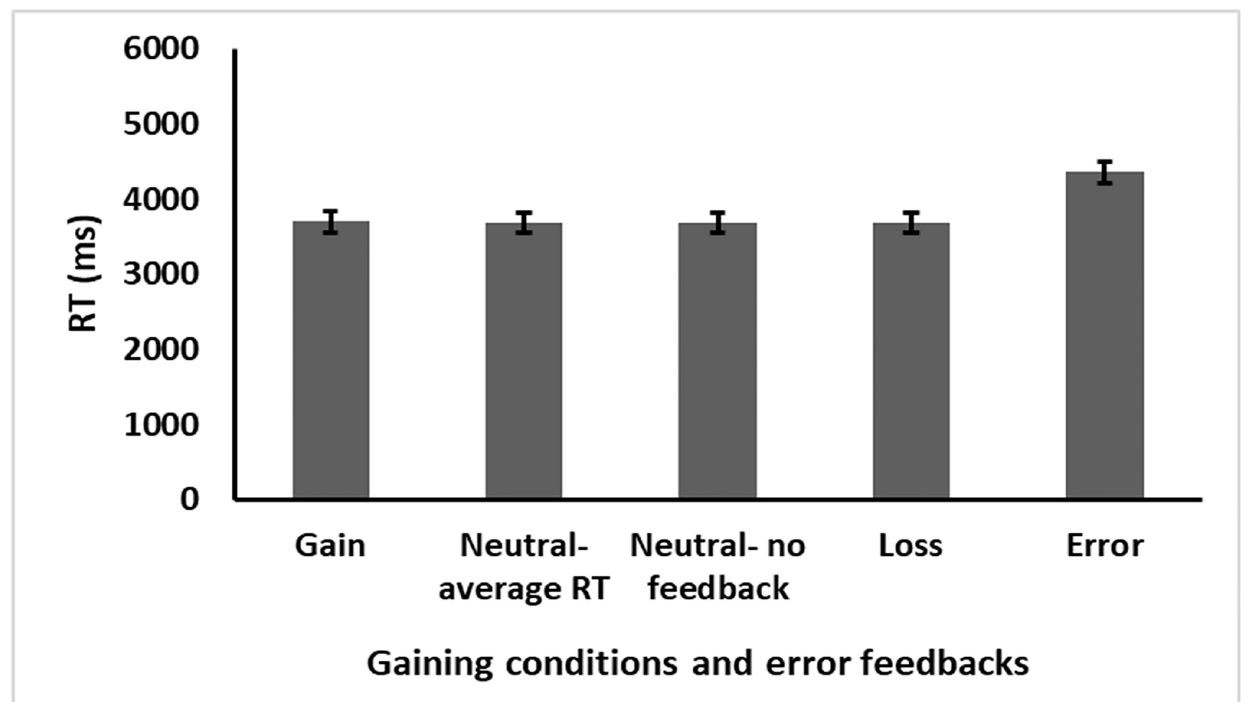
Fig 4. Experiment 2 results. Performance after the different gaining conditions. Error bars represent standard error.